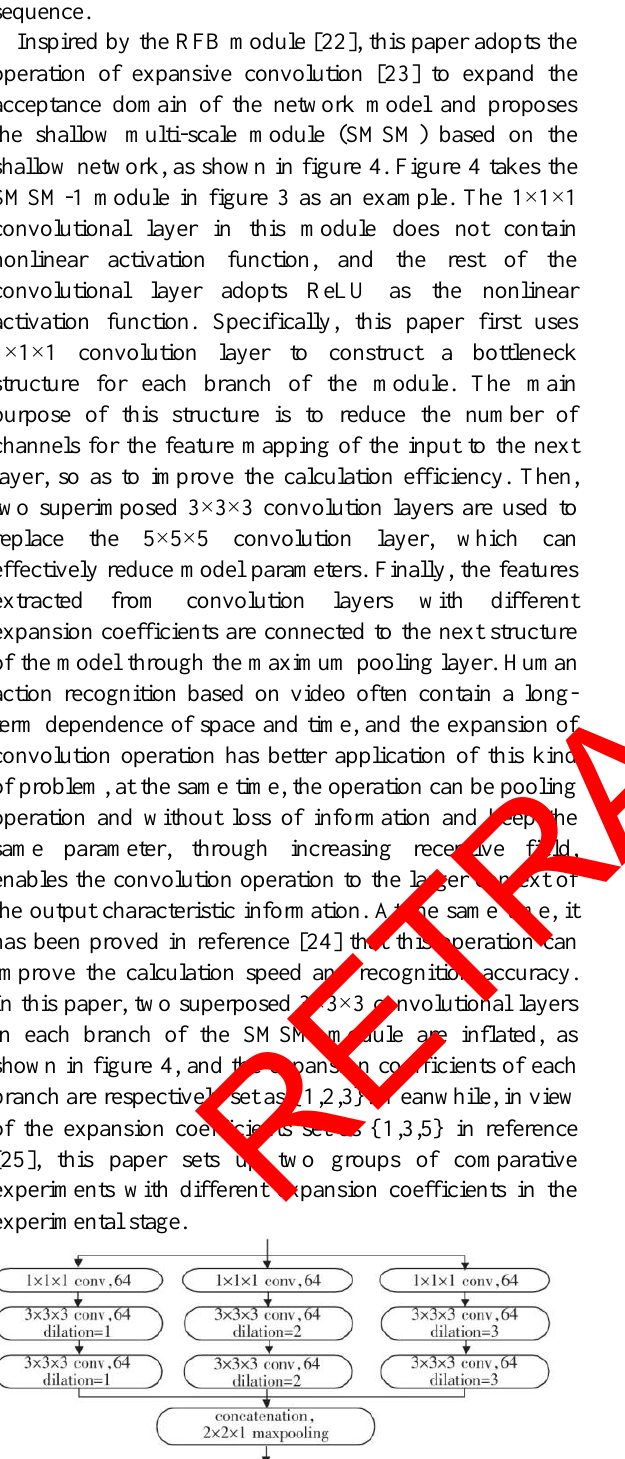
Deep network module